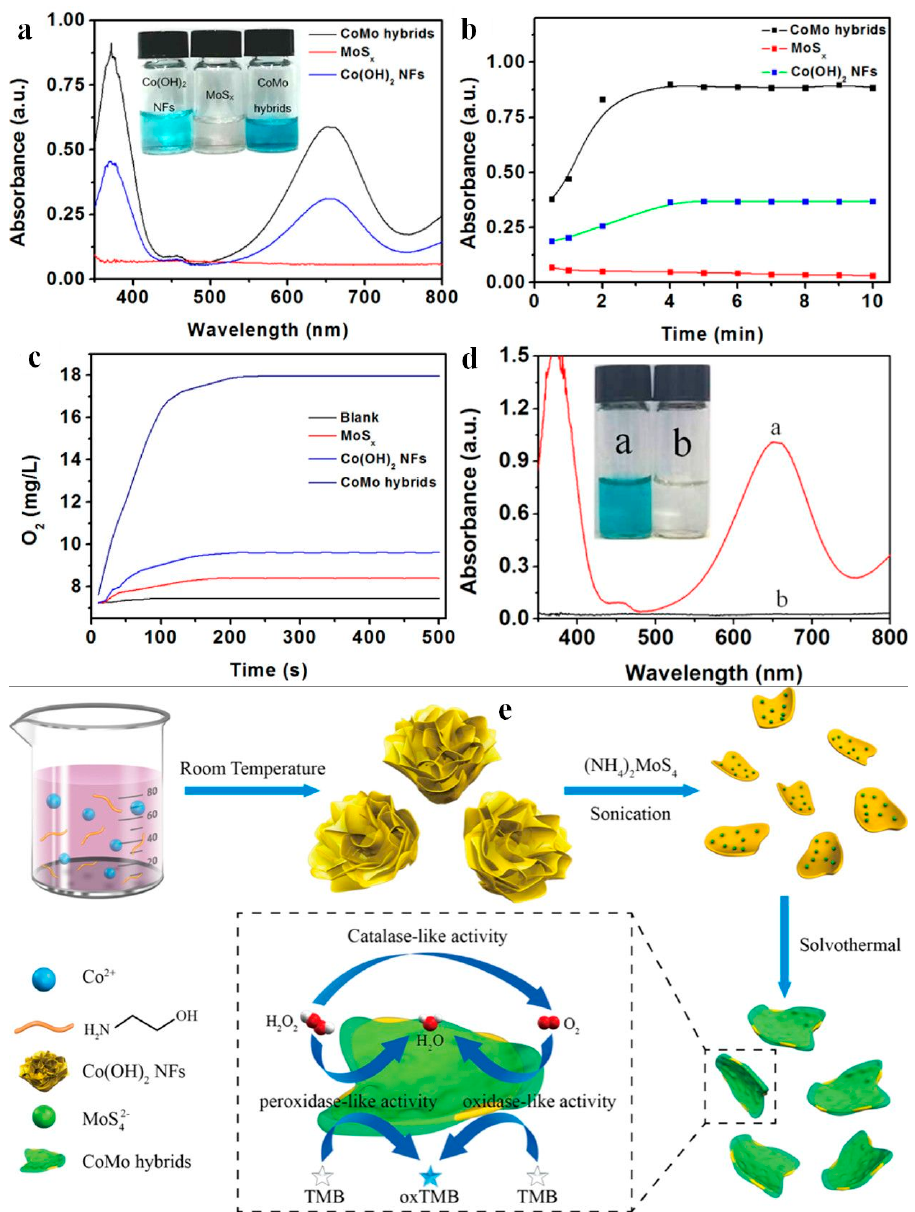
Figure 7. Absorbance intensity of TMB and 50 mM H 2 O 2 upon the addition of different materials ( a ). Time-dependent absorbance of TMB at 652 nm varied with different catalysts used ( b ). O 2 generation from H 2 O 2 decomposition with different catalysts ( c ). Catalytic activity comparison of CoMo hybrids and the supernatant coexisting with the CoMo hybrids ( d ). Visualized reaction scheme to obtain the CoMo hybrids ( e ). Reprinted with permission from (Ding, Y.Q.; Wang, G.; Sun, F.Z.; Lin, Y.Q. Heterogeneous nanostructure design based on the epitaxial growth of spongy MoS x on 2D Co(OH)(2)